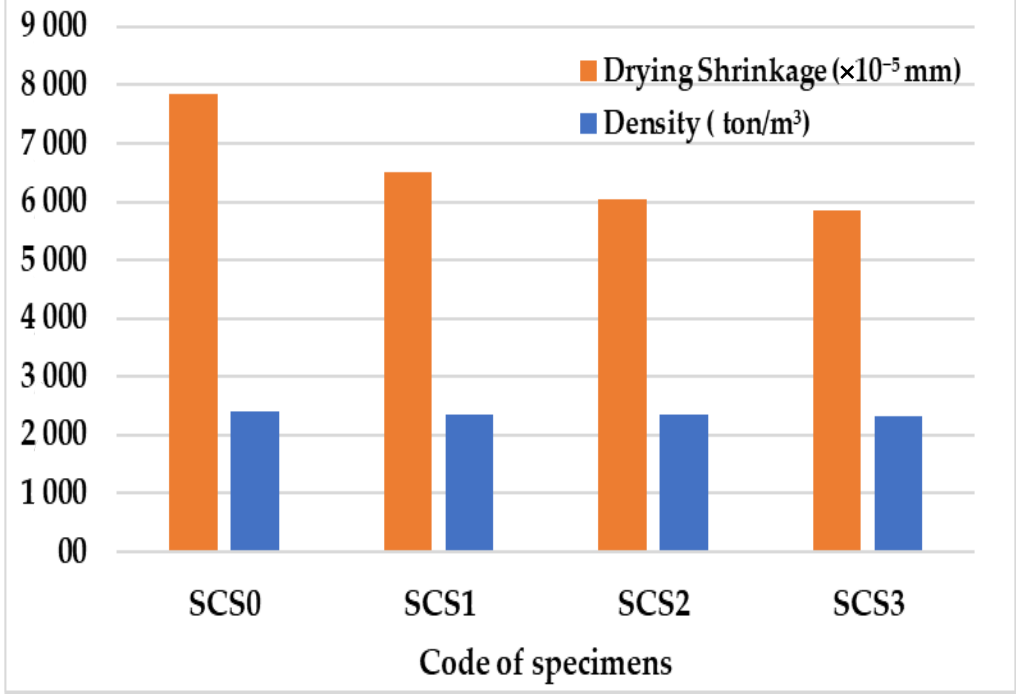
Figure 6. Drying Shrinkage and density of specimens.